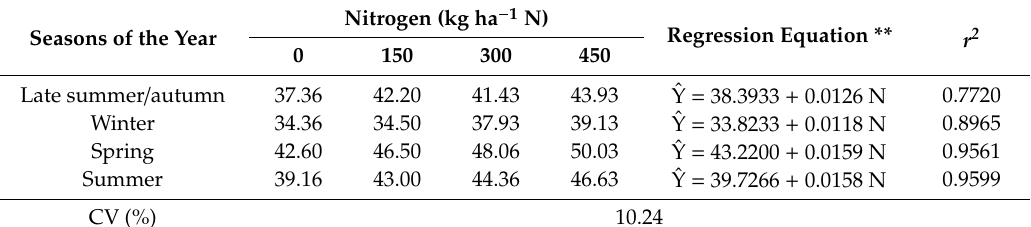
Table 6. Percentage averages of leaf blade in pre-grazing forage mass of Brachiaria brizantha cv. Piatã under rotational stocking and nitrogen fertilization throughout seasons of the year.